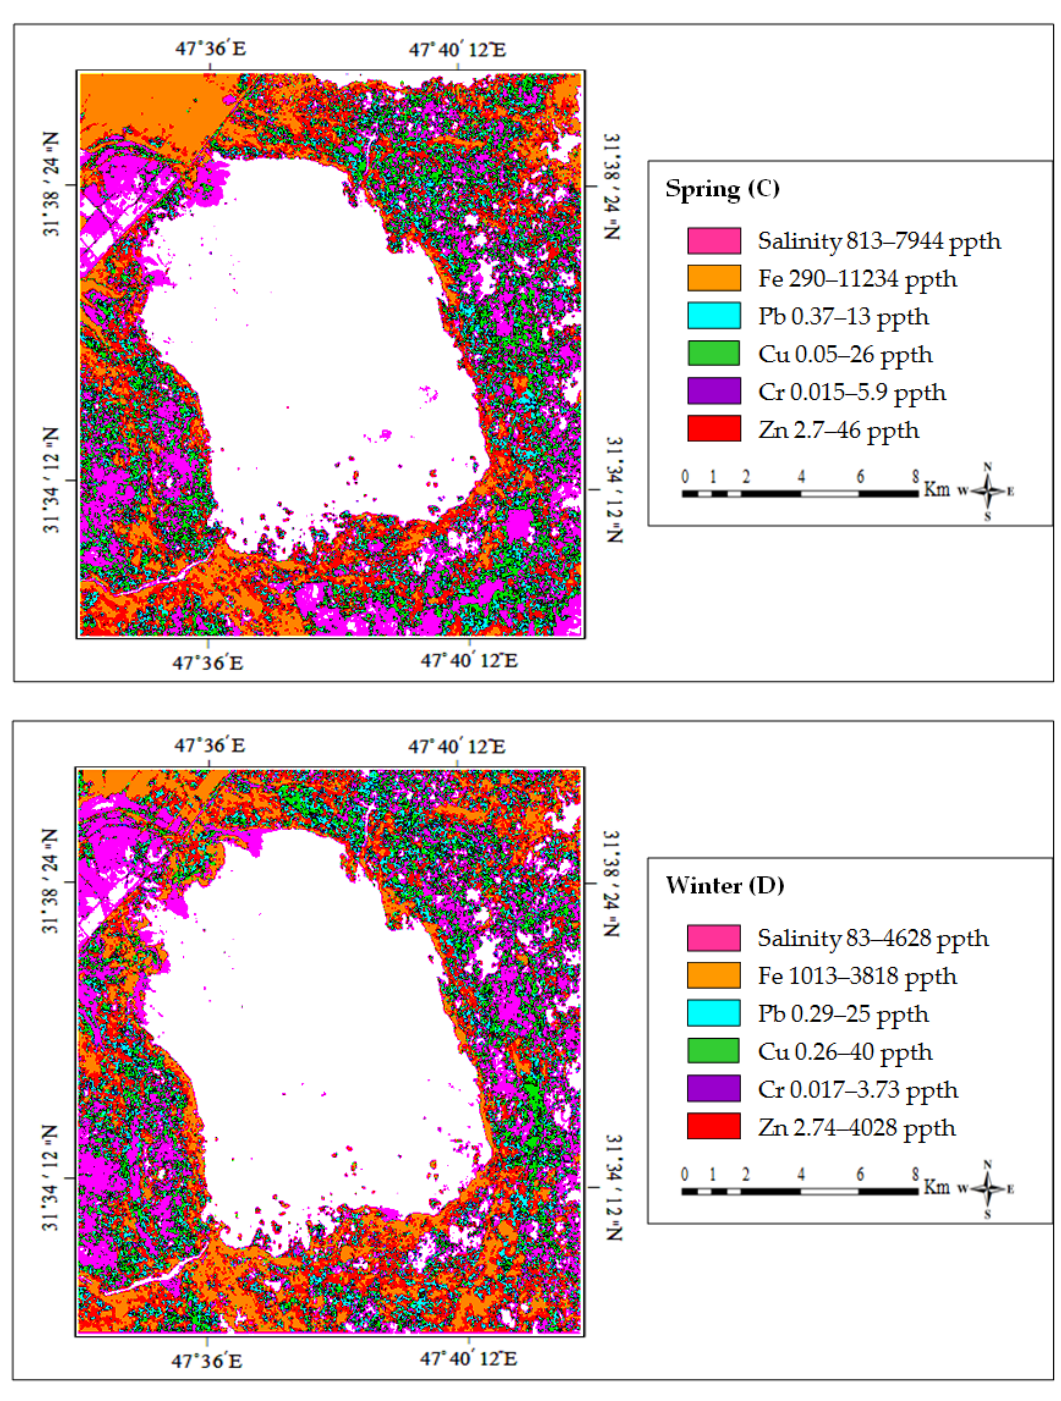
Figure 14. Salinity and chemical spatial distributions of the agricultural lands based on the proposed models during all four seasons: ( A ) autumn, ( B ) summer, ( C ) spring, and ( D ) winter.